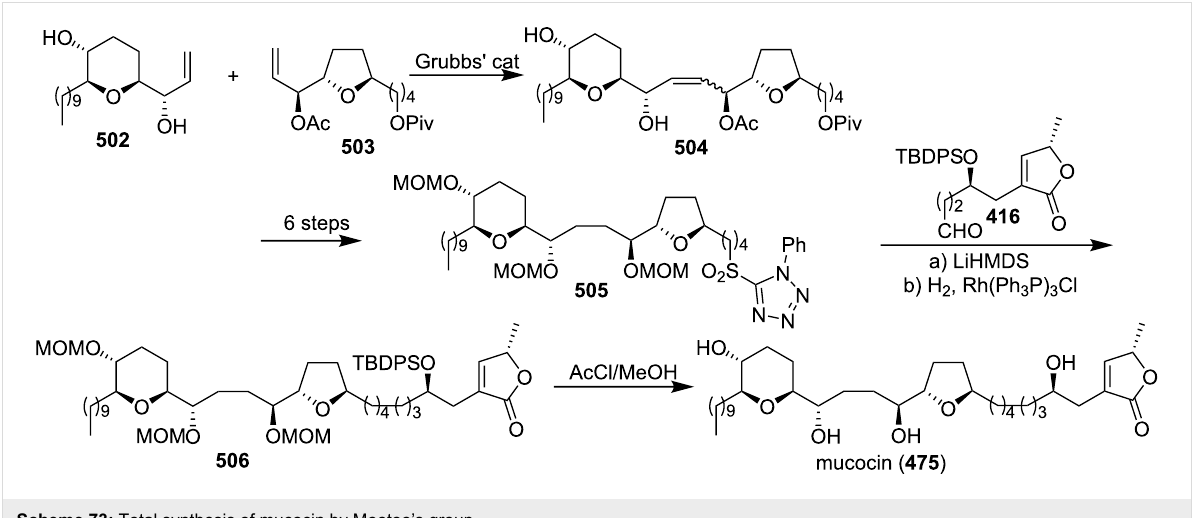
Scheme 73: Total synthesis of mucocin by Mootoo’s